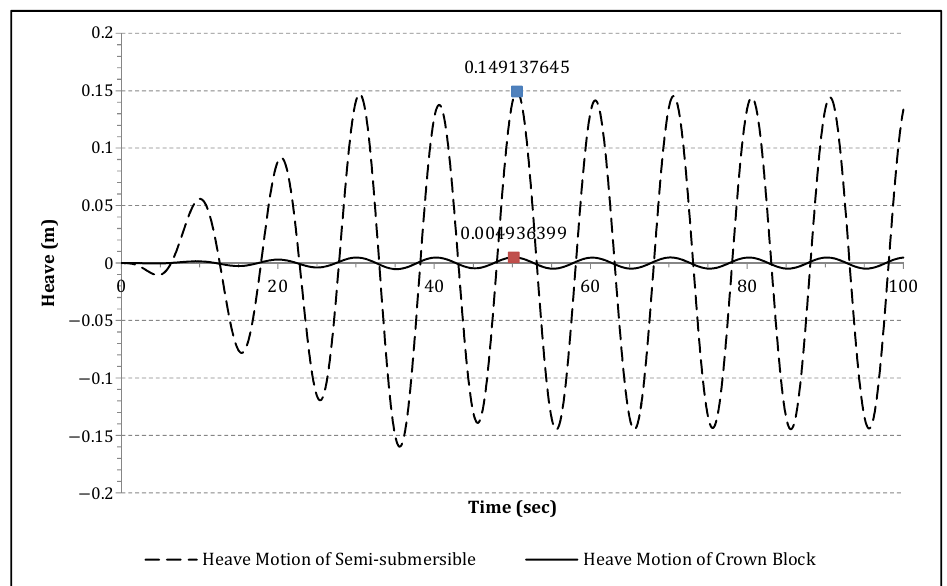
Figure 13. Dynamic response analyses of the semi-submersible and crown block with the heave compensation system for a 1-m wave amplitude.